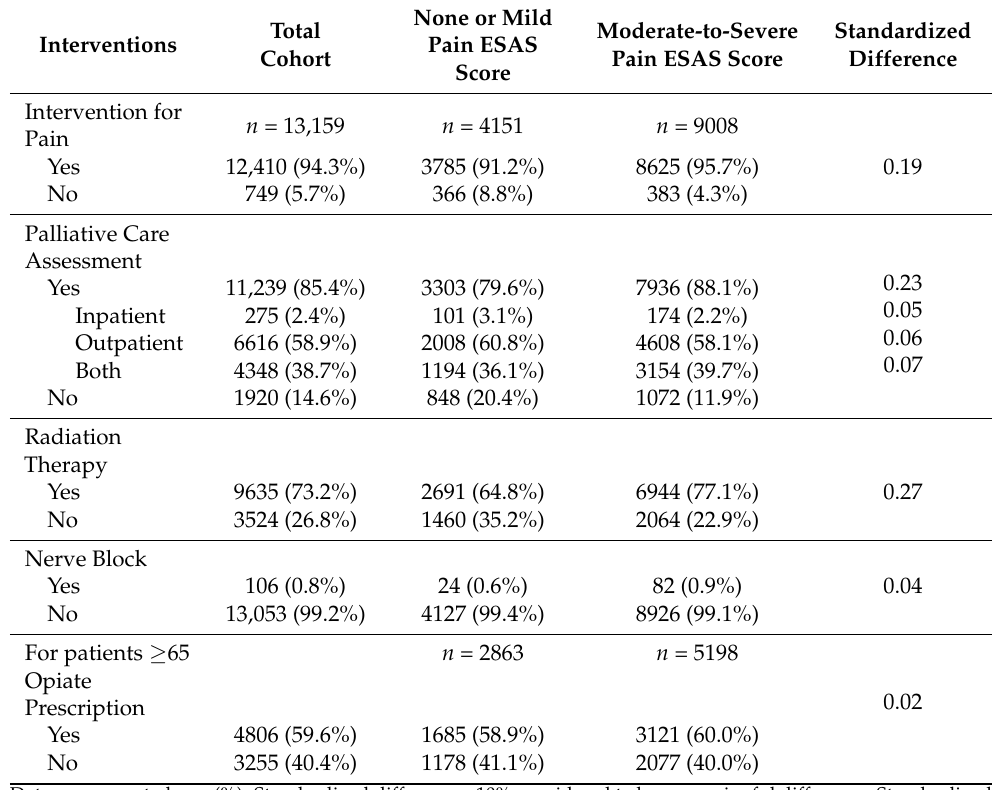
Standardized Difference